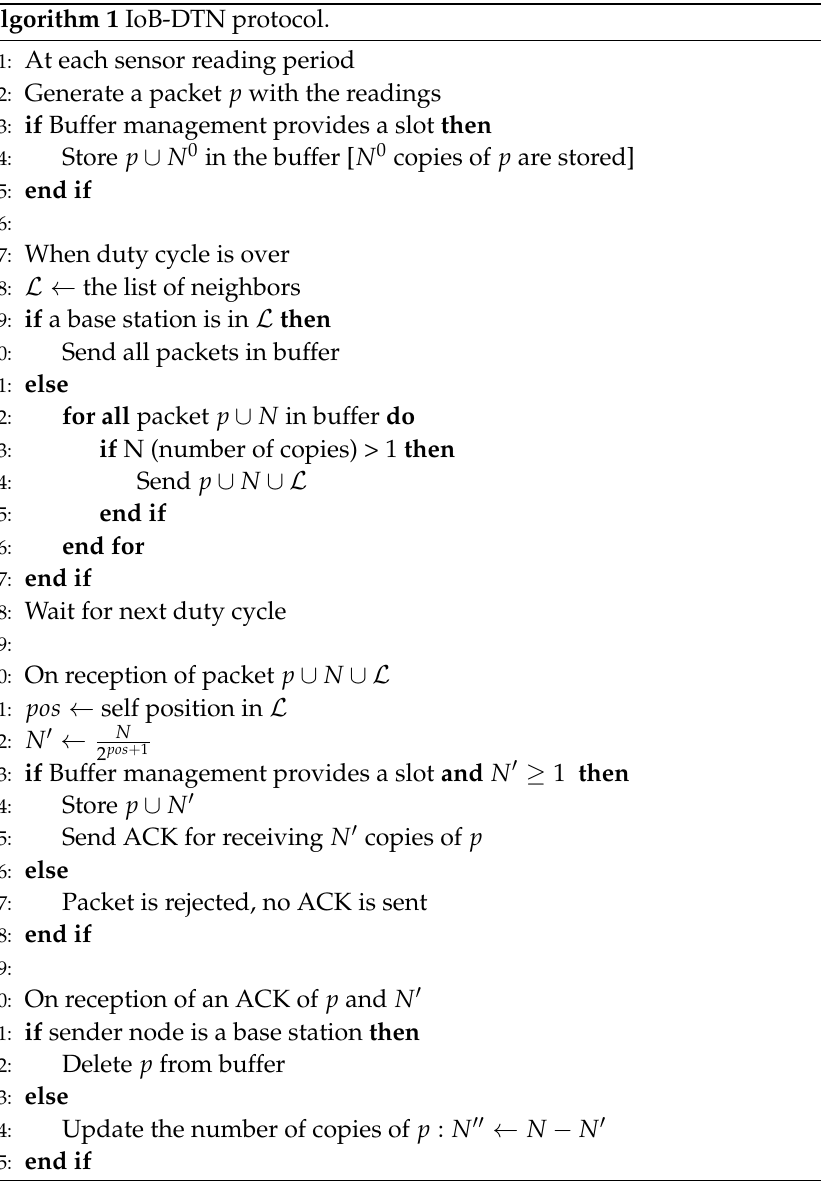
Algorithm 1 IoB-DTN